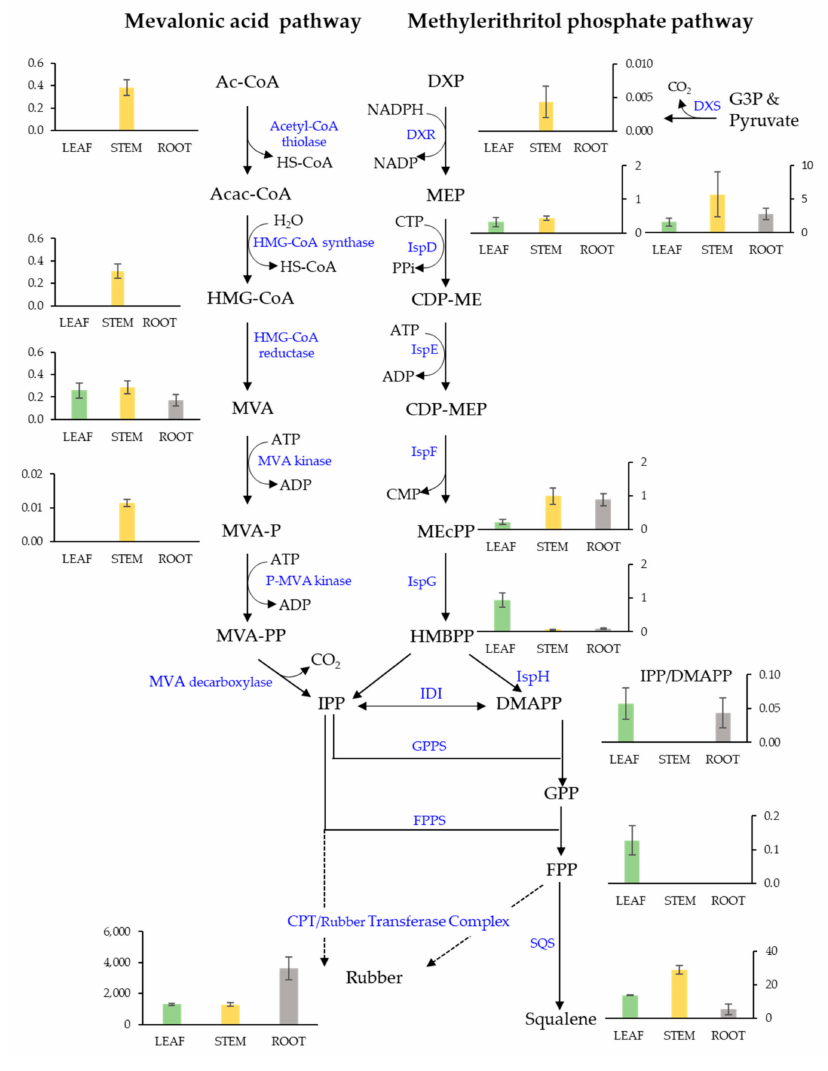
Figure 4. Isoprenoid metabolism in WT guayule. Concentrations ( µ g/g dry weight) of